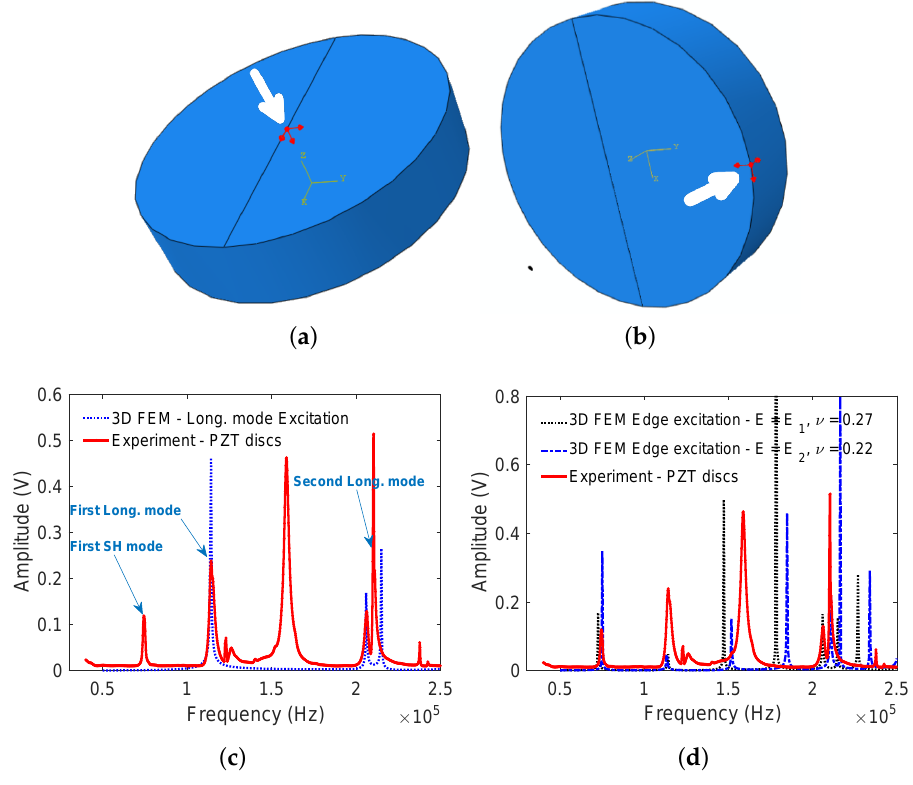
Figure 5. The vibration spectrum obtained using the piezoelectric disc transducers for the ternary disc sample Fe 52 Ti 22 Al 26 (composition given in percentage by weight). ( a ) point concentrated force excitation setup for the longitudinal modes only; ( b ) edge excitation for all modes; ( c ) dotted lines are the 3D finite element method computation of the disc response picked at a node on the opposite face where excitation is applied. The first shear (SH) and Longitudinal (Long.) modes are also shown; ( d ) edge excitation responses showing all the modes with two different values of the pair ( E , ν